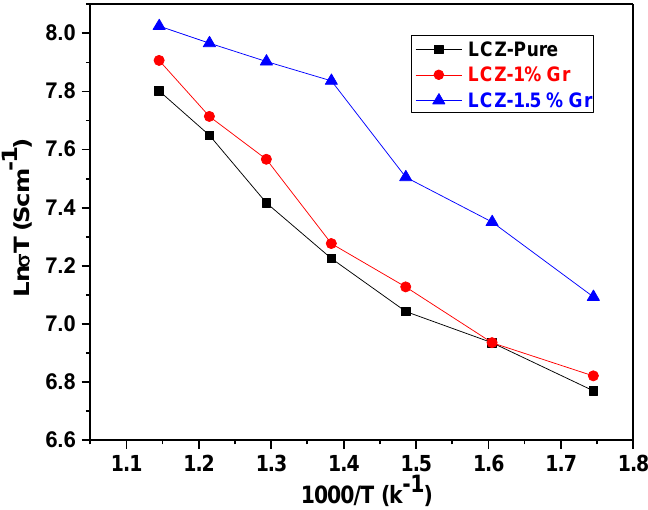
Figure 7. Arrhenius plots: ( a ); LCZ-pure; ( b ) LCZ-1 wt.% Gr ( c ); LCZ-1.5 wt.% Gr.